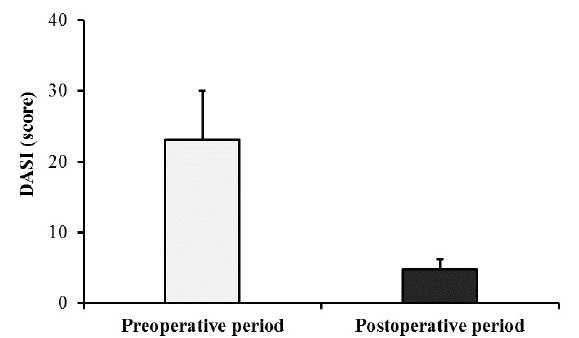
Figure 2 - Patients’ pre- and postoperative Duke Activity Status Index (DASI)